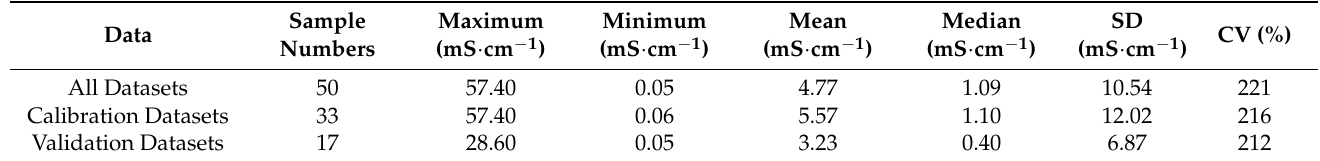
Table 2. Descriptive statistics of EC of soil samples collected in the study